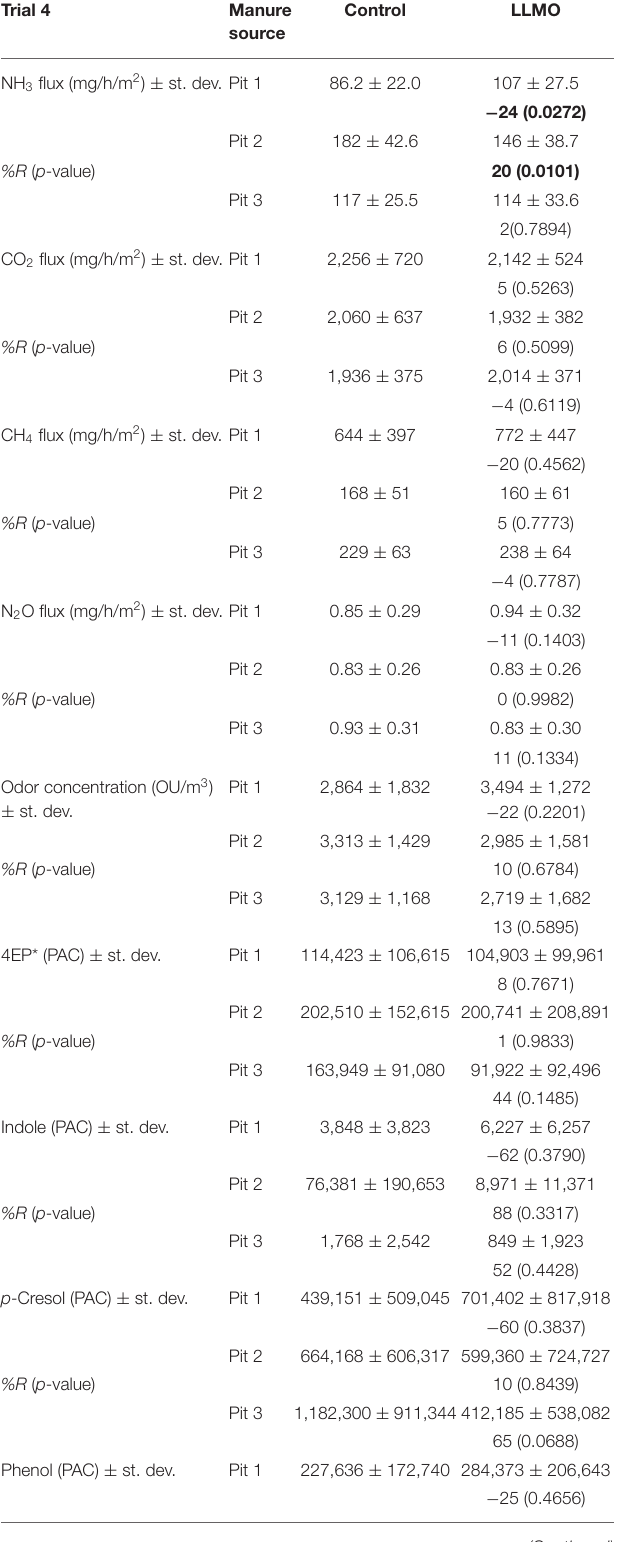
TABLE 9 | Trial 4-comparison of gaseous emissions from each of the three manure sources (farms) with their standard deviations. Trial